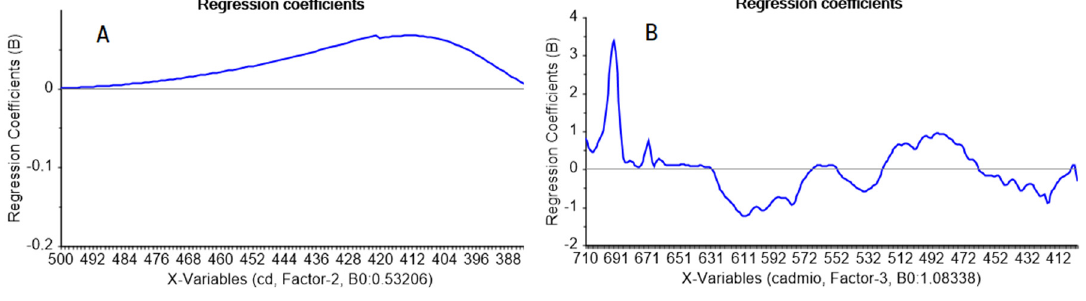
Figure 7. Regression coefficients of the VIS ( A ) and MID-FTIR ( B ) analyses as a function of wavelength (500–390 nm) or wave number (710–400 cm − 1 ), respectively.